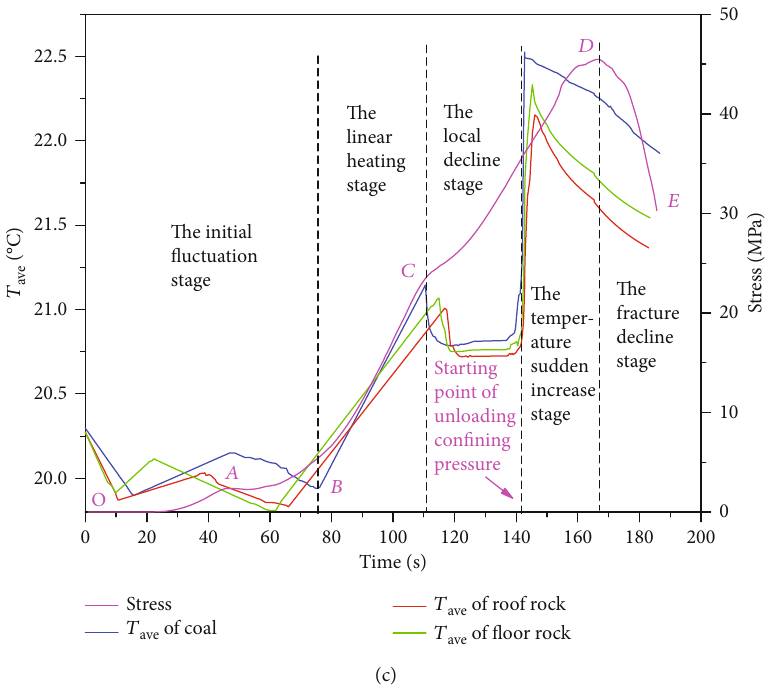
σ - t curve of composite coal-rock. Among them, (a), (b), and (c) are the T Figure 5: T ave - conditions of 0.003MPa/s, 0.03MPa/s, and 0.05MPa/s con fi ning pressure unloading rate,